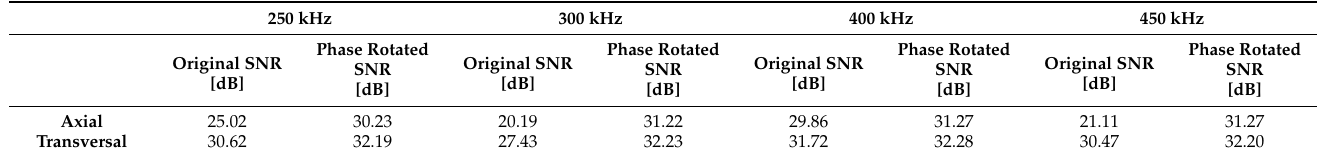
Table 2. SNR Values of original and phase rotated data .